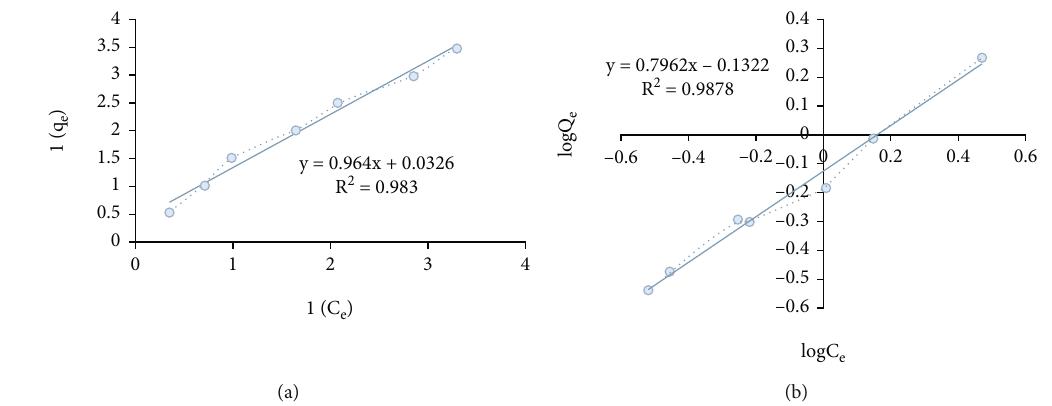
Figure 9: Cr adsorption isotherm (a) Langmuir and (b) Freundlich. Table 4: Langmuir and Freundlich constants for the adsorption of